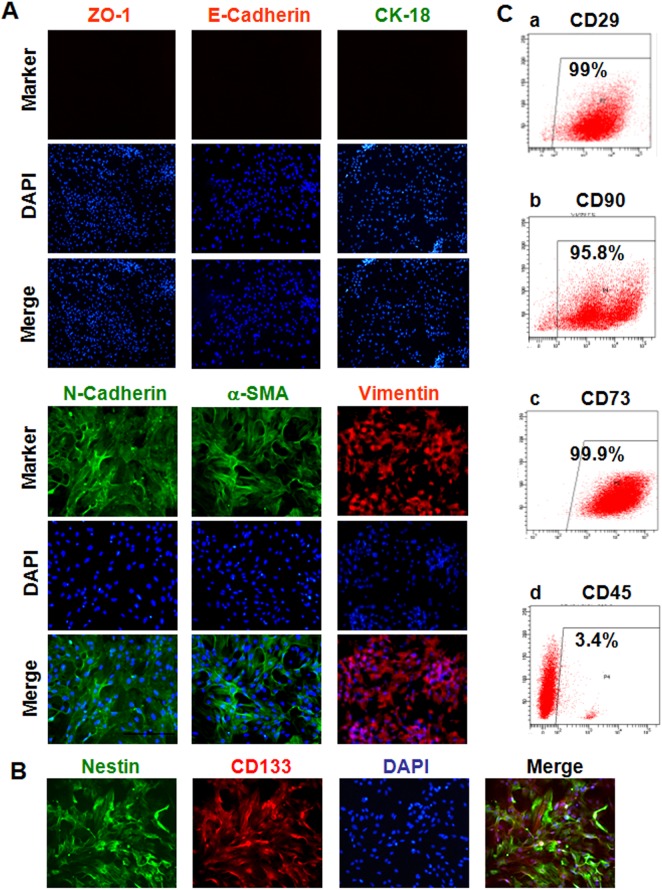
Phenotypic characterization of renal papillary cells.(A) Immunofluorescence analysis for markers of activated fibroblasts (α-SMA, green; Vimentin, red), mesenchymal stem cells (N-cadherin, green), and epithelial cells (CK18, red; E-cadherin, green; ZO-1, red). Nuclei were counterstained with DAPI (blue) (Magnification: ×100). (B) Immunofluorescence staining for the stem cell expression makers Nestin (green) and CD133 (red). Nuclei are stained with DAPI (blue). (Magnification: ×200). (C) Flow cytometry analysis for the MSC markers CD29 (i), CD90 (ii), and CD73 (iii), and the hematopoietic stem cell marker CD45 (iv).